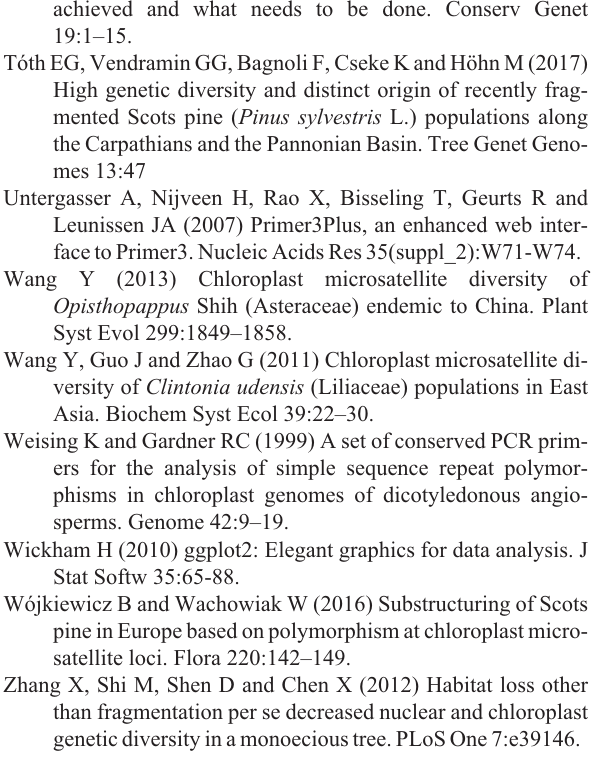
Table S1 - Characterization of the new 13 microsatellite loci specific to E. ovata . Table S2 - Characterization of 13 microsatellite loci in four subpopulations of E. ovata . Table S3 - Frequency of E. ovata haplotypes in the five study areas. Figure S1 - Allele frequencies of the 13 nSSR loci in four subpopulations of E. ovata . Figure S2 - Mean allelic pattern with standard deviation of the 13 nSSR loci in four subpopulations of E. ovata